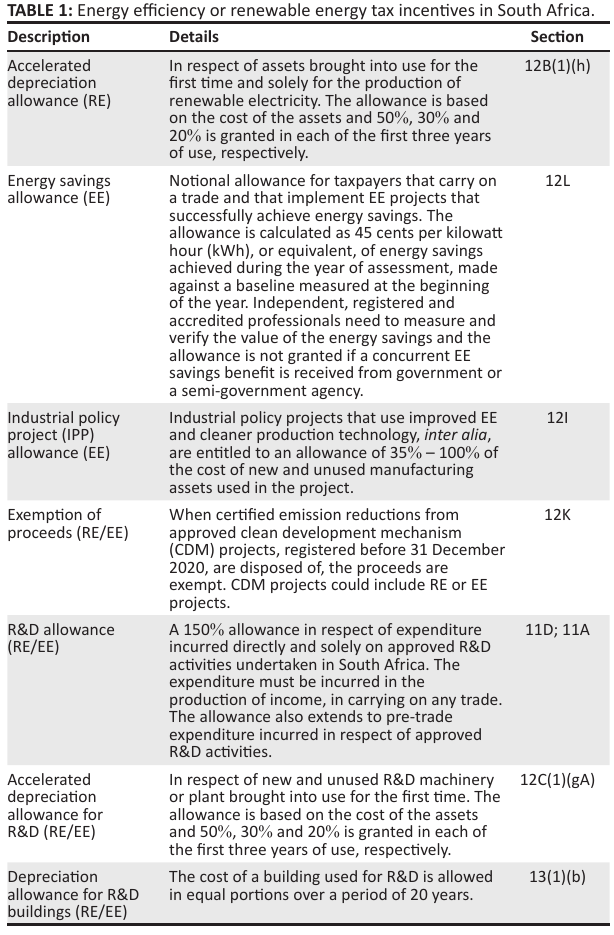
TABLE 2: Respondents that utilise the available tax incentives.